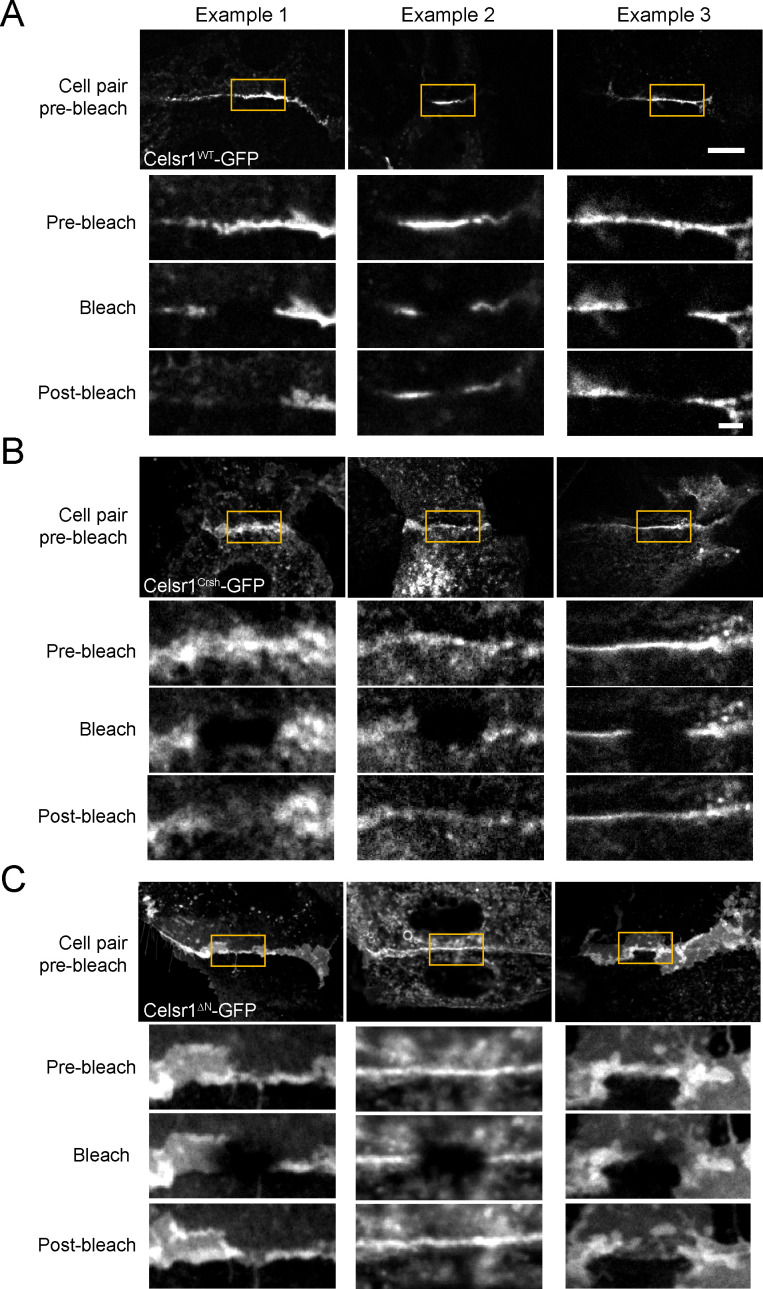
Celsr1Crsh and Celsr1ΔN display altered mobility by FRAP.Additional representative images, three examples each, of FRAP performed on cultured keratinocyte cell borders expressing Celsr1WT (A), Celsr1Crsh (B), and Celsr1ΔN (C). Yellow box highlights bleached regions, magnified below for the timepoints indicated. Pre-bleach and post-bleach images shown are at −10 s and 5 min respectively. Scale bars, 10 µm; insets, 2 µm.